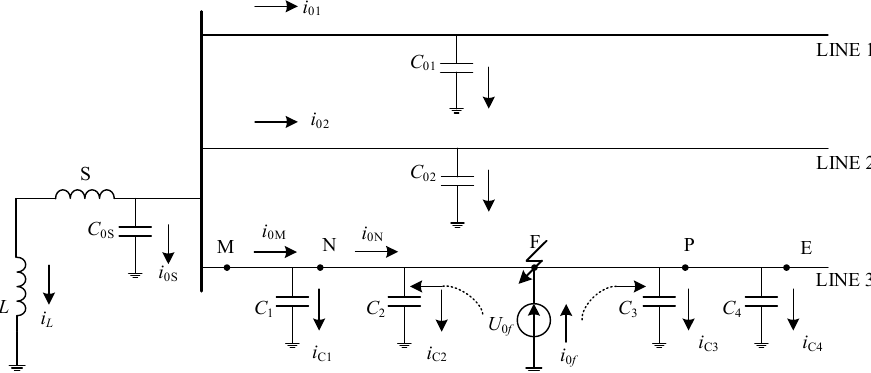
Figure 1. Transient equivalent circuit of single-phase grounding fault in resonant grounding system. Here,